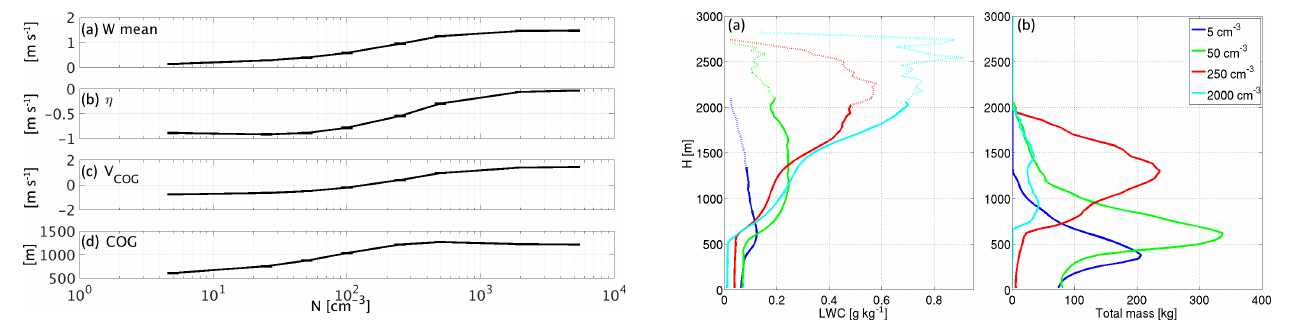
Figure 4. (a) Mean LWC vertical profiles. (b) Vertical profiles of the mean (over time) total liquid water mass per height for four different simulations (5cm − 3 – blue; 50cm − 3 – green; 250cm − 3 – red; and 2000cm − 3 – cyan). The mean profiles are calculated for the last 14h of the 16h of simulation. Note that dotted parts of the curves in (a) represents heights at which the total liquid water mass was less then 1% of the maximum total mass (Fig.